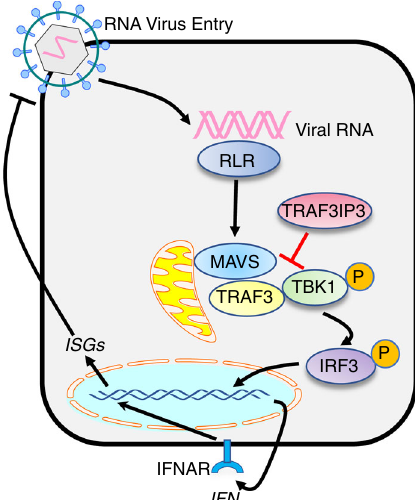
Fig. 8 Schematic illustration of TRAF3IP3 serving as immune rheostat by inhibiting RLR dependent IFN-I pathway. TRAF3IP3 inhibits the RLR sensing pathway by targeting at node of TBK1 and